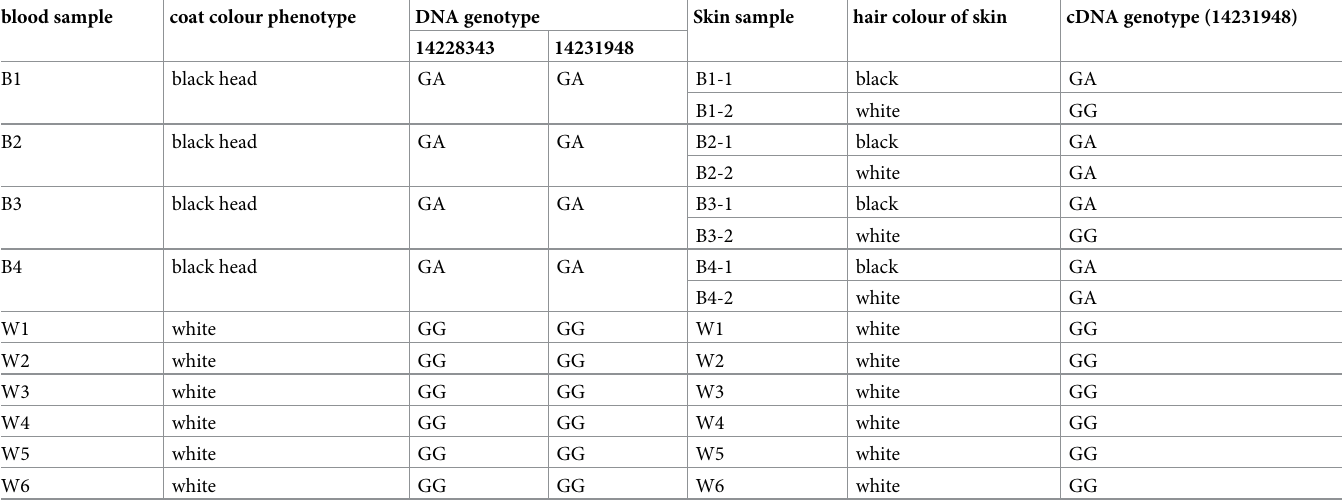
Table 3. DNA genotyping and allele-specific expression (ASE) analysis for two candidate loci: chr14:14228343 (rs408511664) and chr14:14231948 (rs409651063). blood sample coat colour phenotype